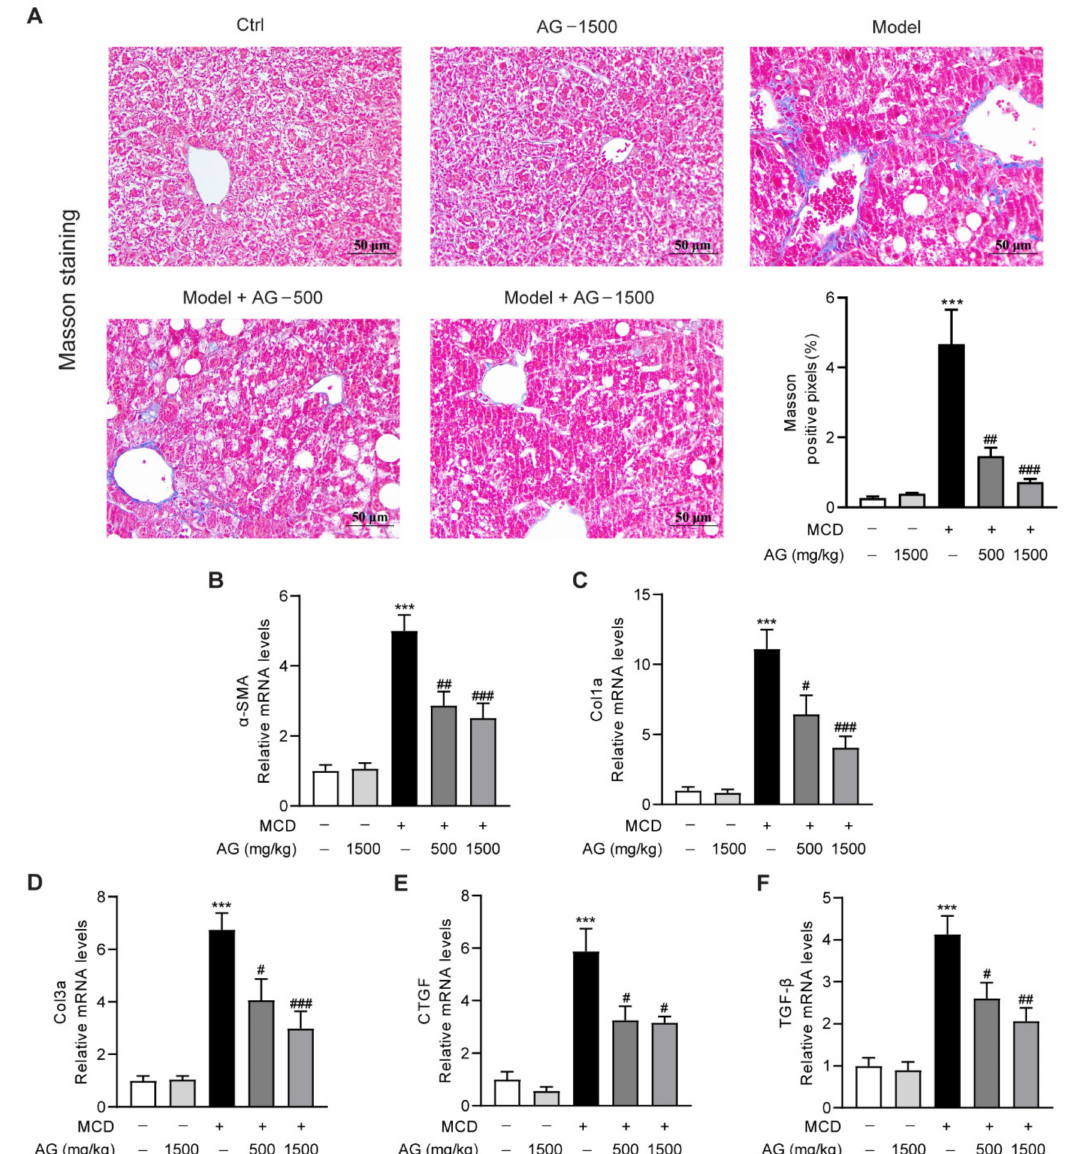
Figure 5. The anti-fibrosis activity of Ala-Gln in MCD-fed mice. ( A ) Representative Masson’s trichrome staining images ( × 400) in liver. ( B – F ) The mRNA levels of α -SMA, Col1a, Col3a, CTGF, and TGF- β in liver. Data are expressed as the mean ± SEM. *** p < 0.001, compared to the Ctrl group; # p < 0.05, ## p < 0.01, ### p < 0.001, compared to the Model